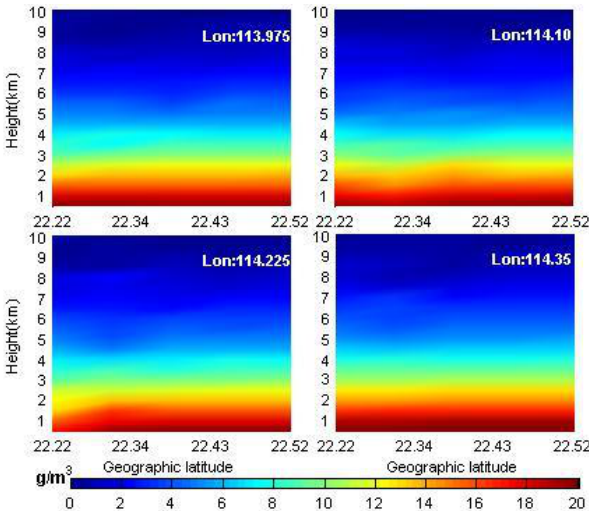
Fig. 7. Vertical profiles of tomographic water vapor at four different longitudes on July 23, 2012.